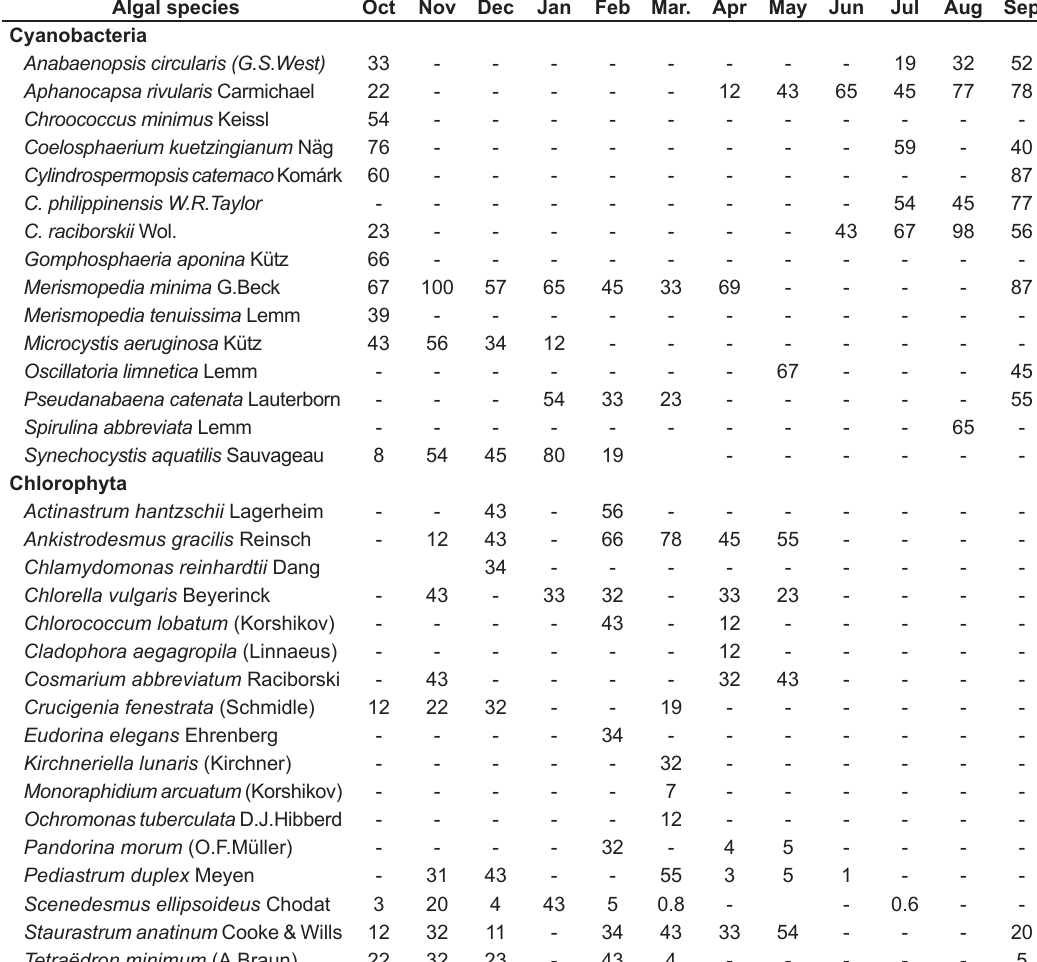
Table 3. Analysis of different phytoplankton groups identified in fish gut (cells x10 6 gut -1 ) from fishpond 2 during the study period Oct. 2012- Sept.